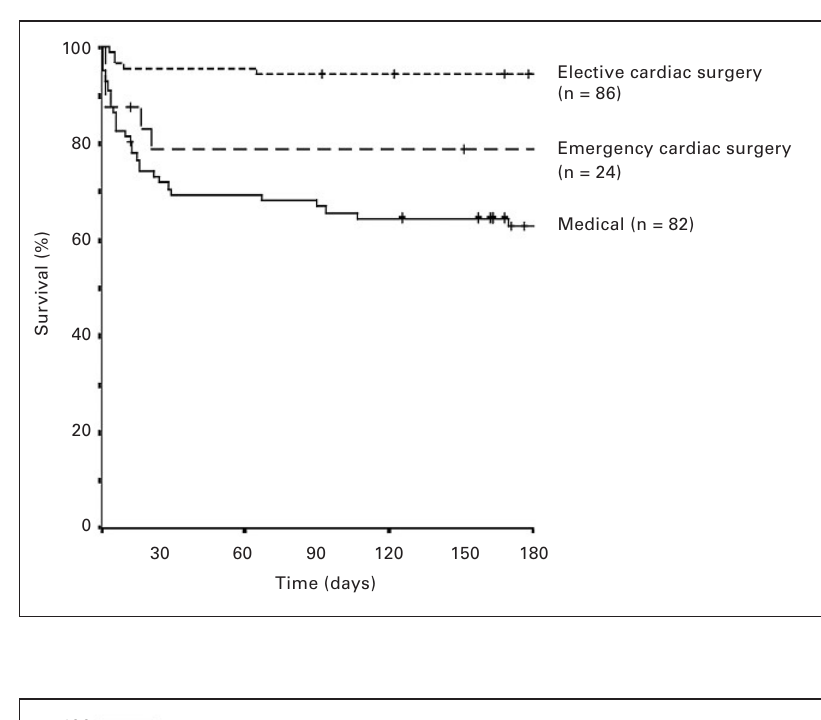
The Kaplan Meier curves show survival rates of ICU-patients with different acute heart failure syn- dromes over time, starting at the day of ICU admission.The small vertical lines in- dicate the time points when patients had their last follow up. The survival curves between the groups were significantly different (Log Rank p <0.001).The 6 pa- tients with sepsis- induced myocardial depression are not included in this graph.